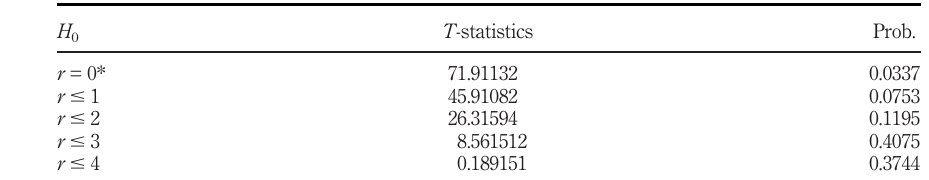
H 0 T -statistics